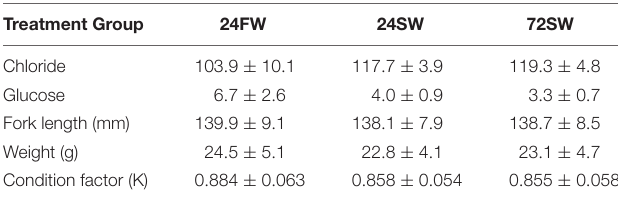
TABLE 3 | Mean and standard deviations for each blood parameter and physical measurements for each treatment